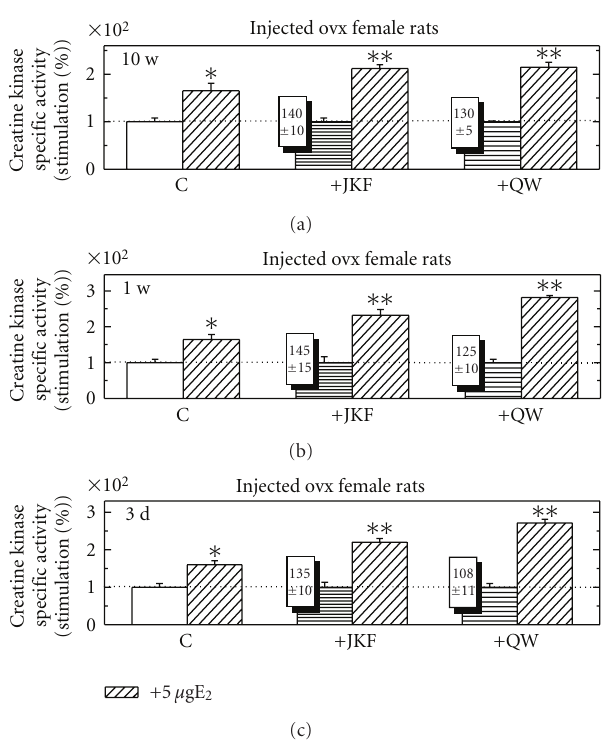
Figure 9: The e ff ect of pretreatment with JKF and QW at 0.2ng/g/rat/d for 10 weeks (a), 1 week (b) or 3 days (c) on CK activity in Pi from OVX female rats compared to the stimulation of E 2 at 5 μ g/rat and to the combination of the vitamin D analogs and E 2 . Treatments were as described in Section 2. Results are expressed as the ratios between the specific activities of CK in hormone- treated and vehicle-injected control animals. The basal activity of CK in was 0 . 76 + 0 . 08 μ mol/min/mg protein, n = 5. ∗ P < . 05, ∗∗ P < . 01 in the di ff erence compared to vehicle.